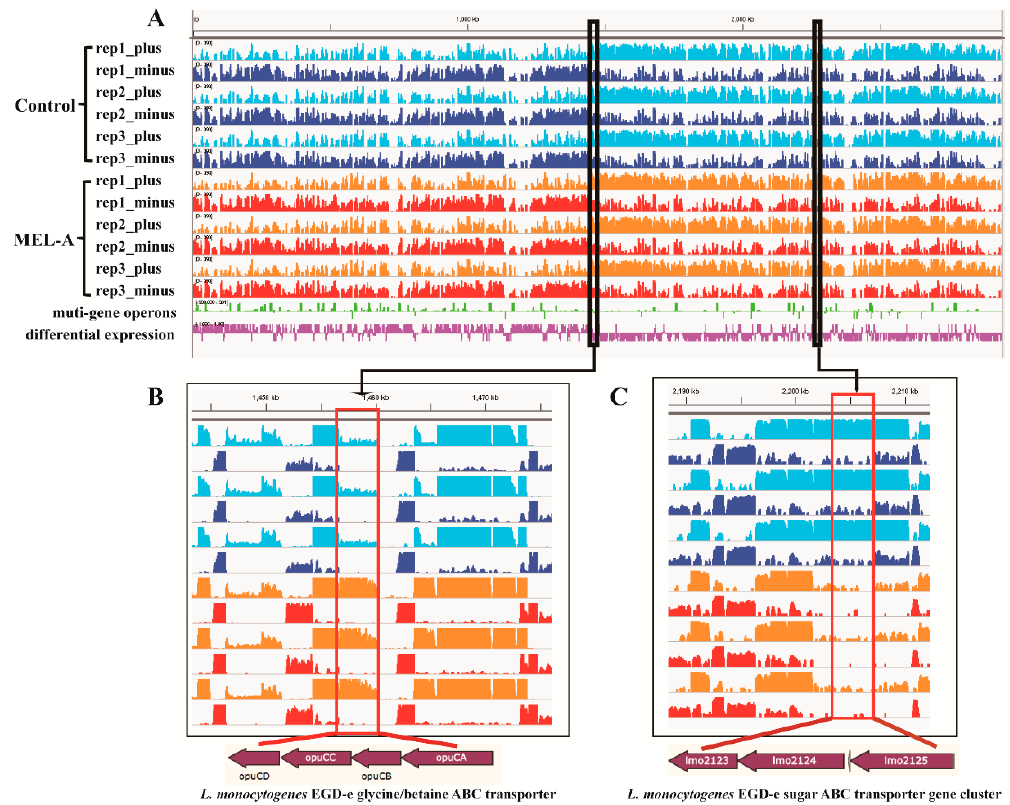
Figure 7. Transcriptome analysis of L. monocytogenes : ( A ) coverage plots of RNA-seq data aligning to chromosome DNA. The y axis represents the reads coverage while the x axis denotes the genomic location. Light blue (control) or orange (MEL-A) tracks are reads aligned to the plus strand and blue (control) or red (serum) tracks are reads aligned to the minus strand. Multi-gene operons are shown in the green track and differentially expressed genes are expressed in purple track. ( B ) An upregulated gene cluster related to glycine / betaine ABC transporter. ( C ) A downregulated gene cluster related to sugar ABC transporter.